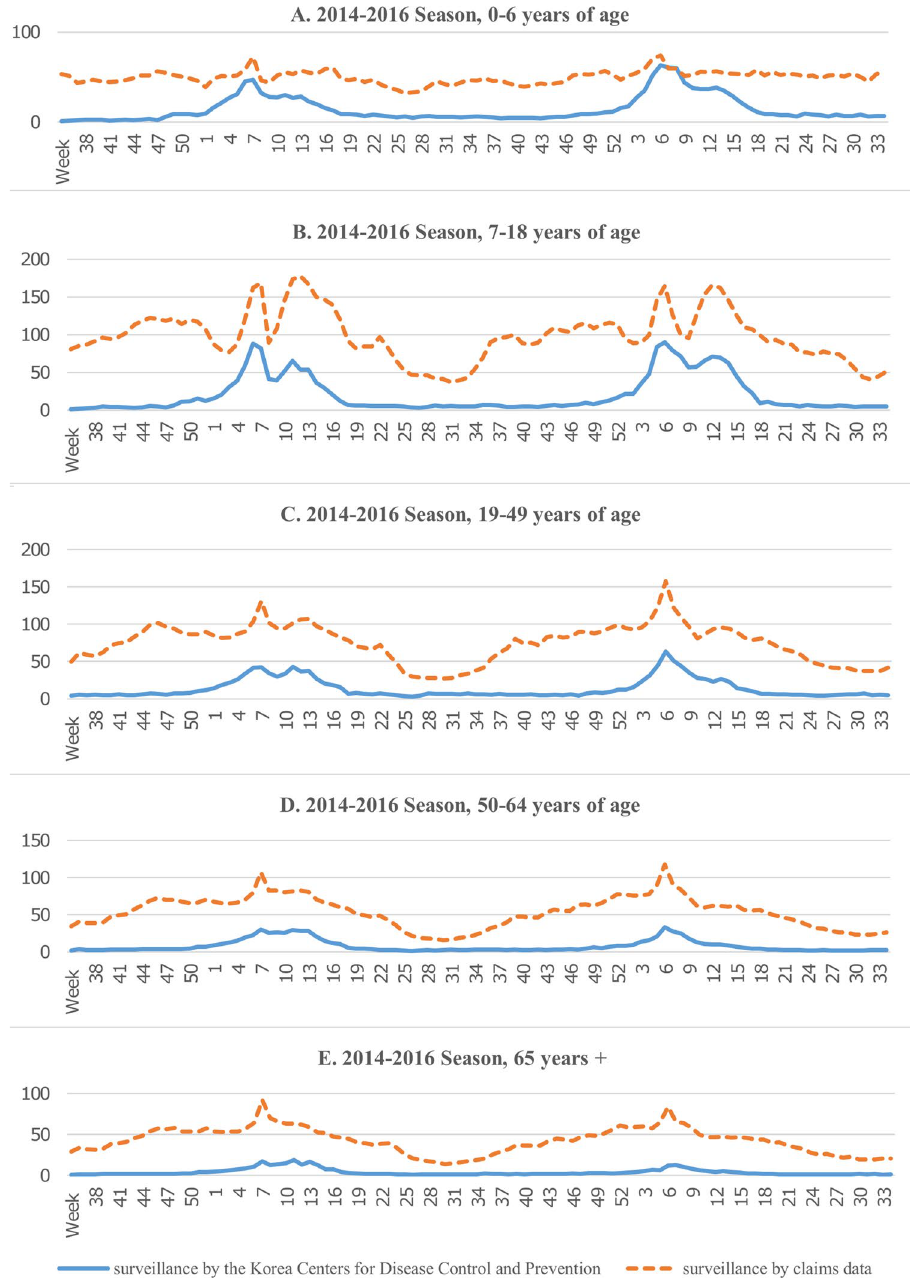
Figure 3. Comparison of the ILI-related claims rate and clinical sentinel surveillance report by age group,